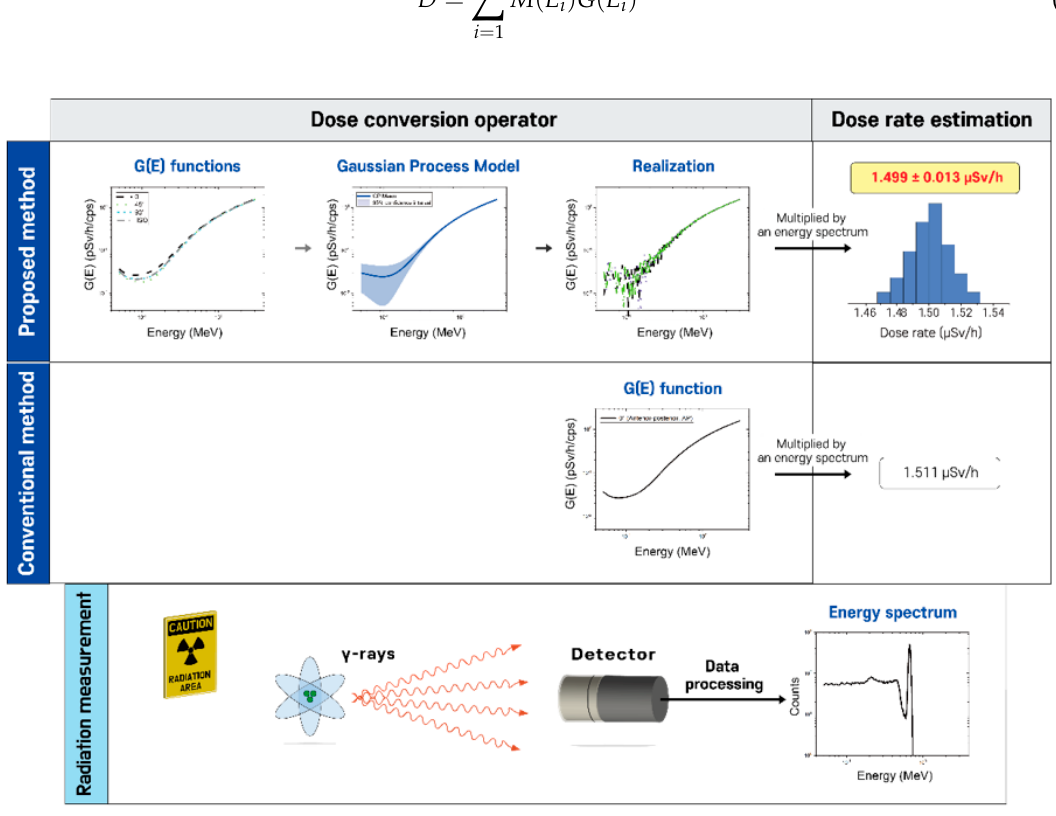
Figure 1. Illustration of the proposed concept of dealing with uncertainty in dose rate estimation compared with the conventional method.